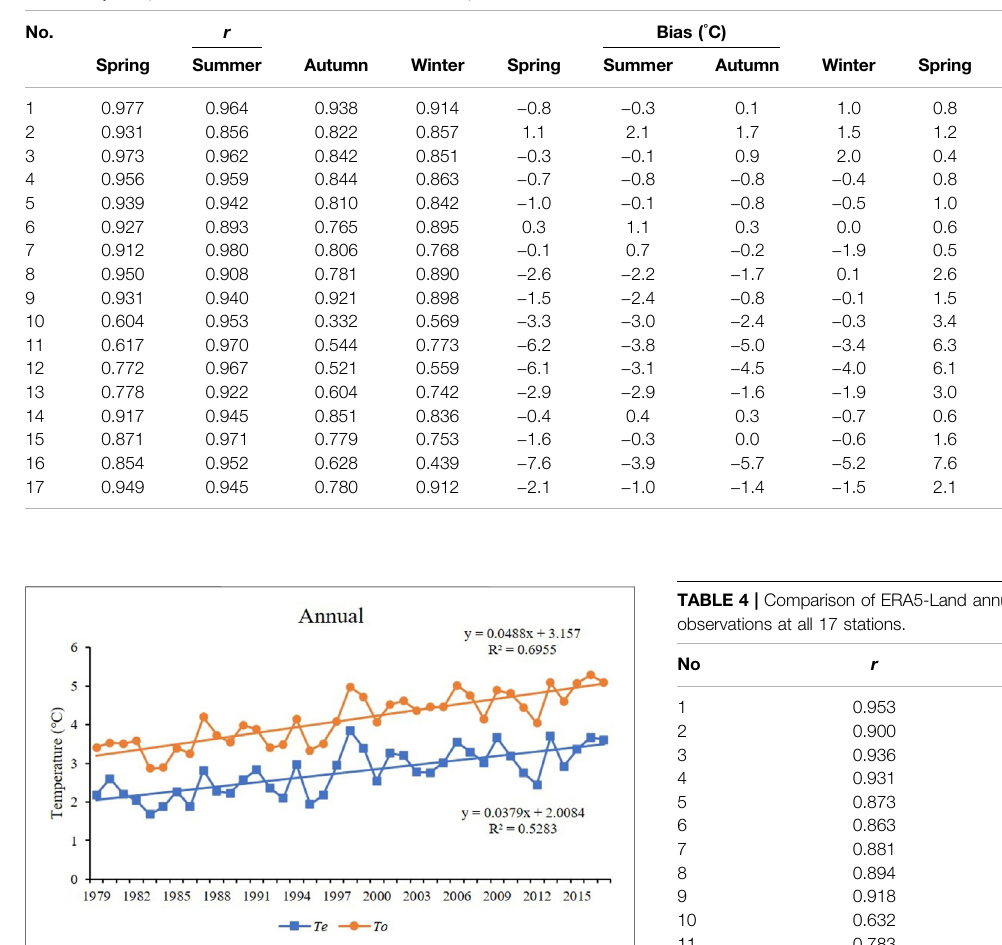
FIGURE 5 | Average annual mean temperature from station time series and ERA5-Land in the 1979 – 2017 period for QLM.